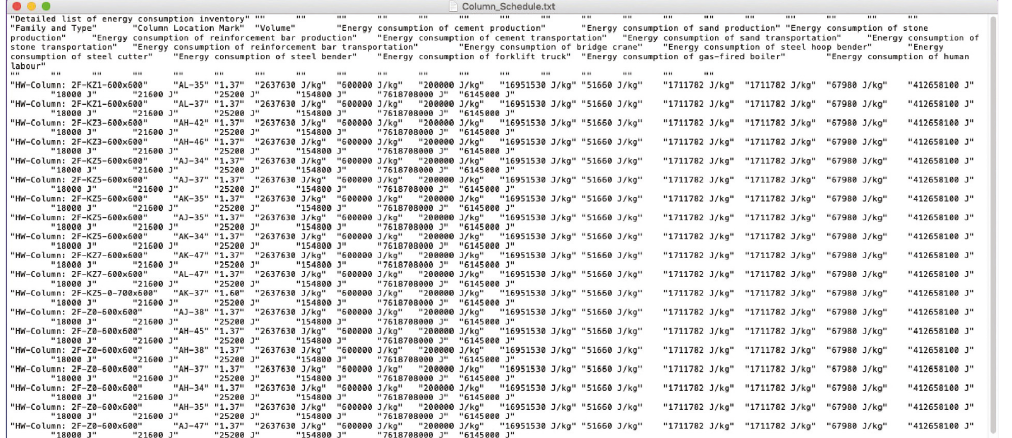
Figure 9: Screenshot of raw material information and energy consumption inventory.